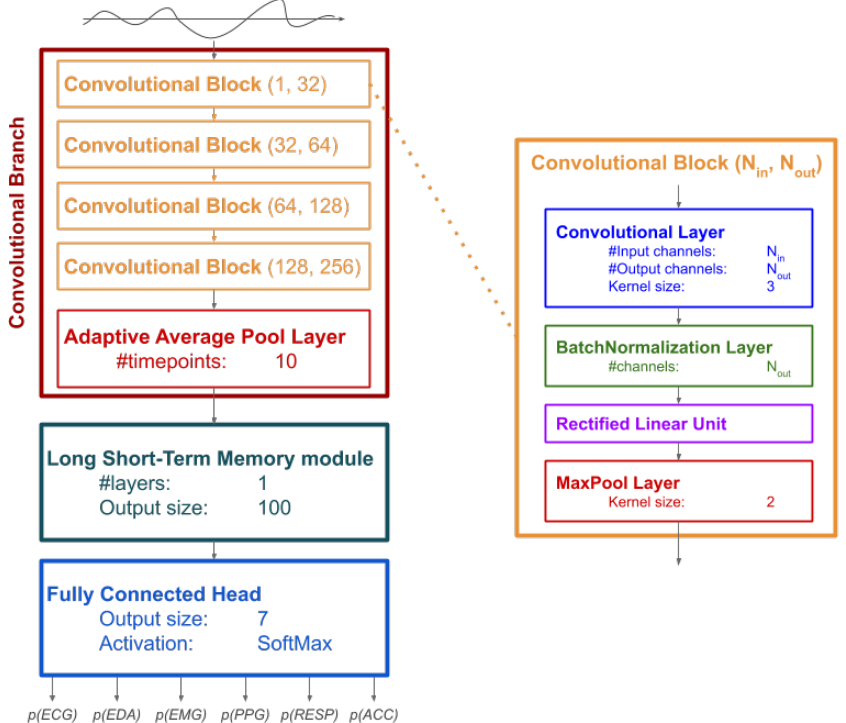
Figure 1. Diagram representing the architecture of the Deep Neural Network (DNN) used in this study. Left: the complete network with the three components (the Convolutional Branch, the Long Short-Term Memory module, and the Fully Connected Head) and parameters used for each layer. The input signal is processed by the DNN to output the probability of belonging to each of the six signal types considered in the study. Right: structure of a general Convolutional Block with N in input channels N out output